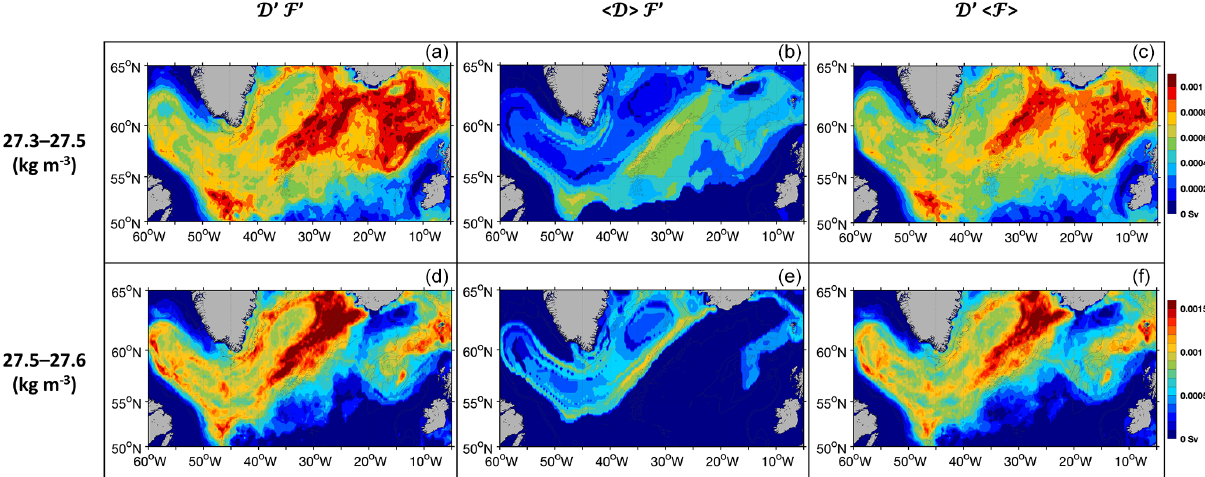
Figure 4. Sensitivity analysis of the variance in transformation estimated as the standard deviation of the yearly transformation integrated over the density range (a–c) 27.3–27.5kgm − 3 and (d–f) 27.5–27.6kgm − 3 layers during 1980–2019. The left column (a,d) shows the variance in transformation estimated from monthly variable surface density ( D (cid:48) ) and air–sea fluxes ( F (cid:48) ); the middle column (b,e) shows the variance in transformation estimated from monthly variable heat and freshwater fluxes ( F (cid:48) ) and climatological surface density ( (cid:104) D (cid:105) ); the right column (c,f) shows the variance in transformation estimated from monthly variable surface density ( D (cid:48) ) and climatological heat and freshwater fluxes ( (cid:104) F (cid:105) ). Variable and climatological density at surface stand for variable and climatological salinity and temperature at surface.